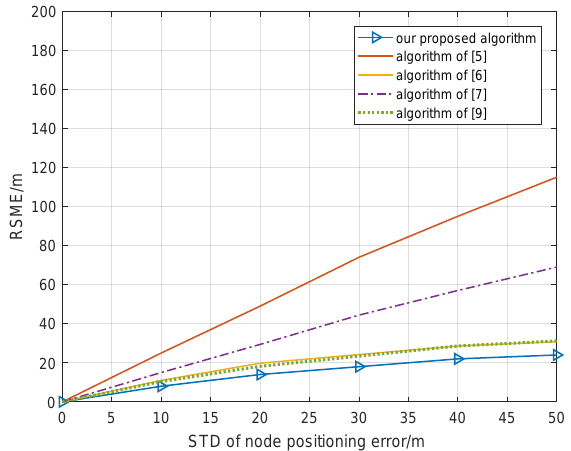
Figure 4. Relationship cooperative position error and node positioning error with ideal position condition.